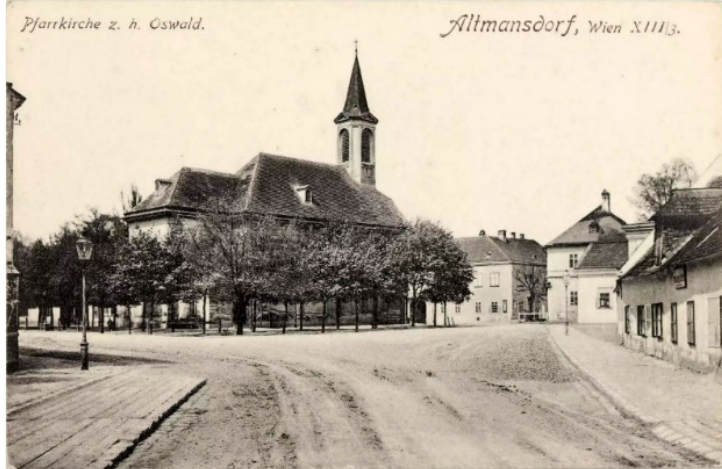
Figure 9. Khleslplatz with the church of Altmannsdorf: Postcard, 1909. Source: Ledermann (1909).